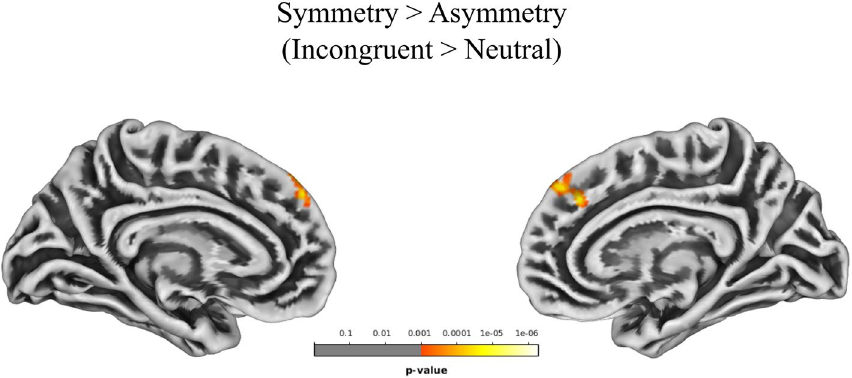
Figure 3. Difference in brain activity between individuals with Symmetric and Asymmetric aMCC sulcation patterns for the Incongruent > Neutral contrast. Significant results are shown at cluster level FWE-corrected for multiple comparisons p-value < 0.05, and vertex level uncorrected p-value <